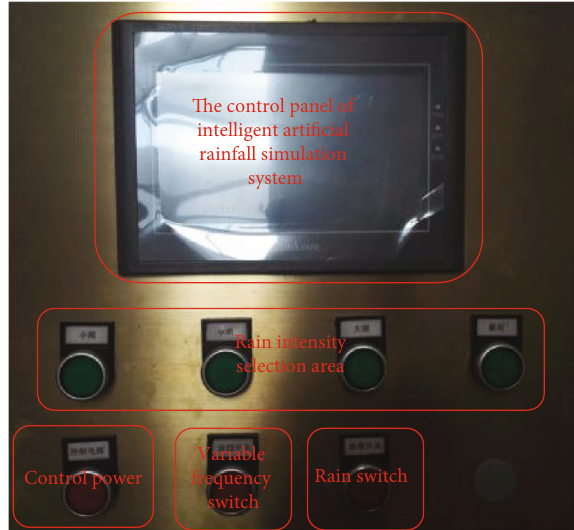
Figure 3: The rainfall control